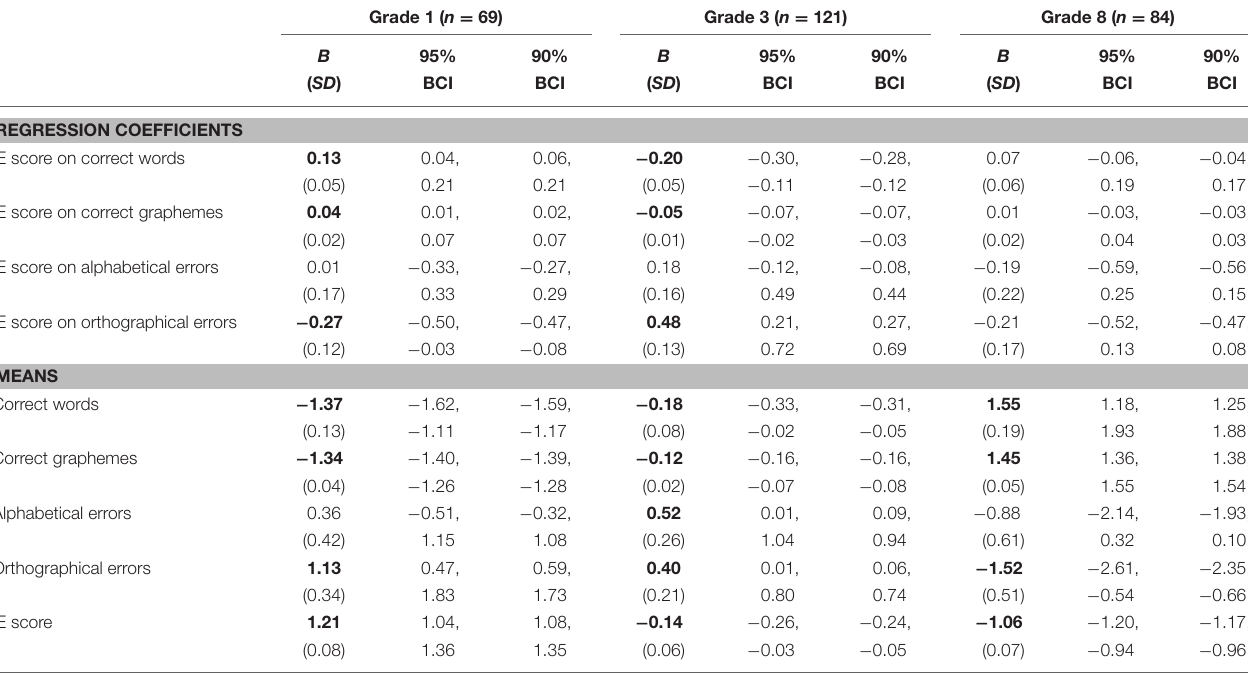
TABLE 2 | Results of difference tests for structural age invariance analyses in the full non-invariant